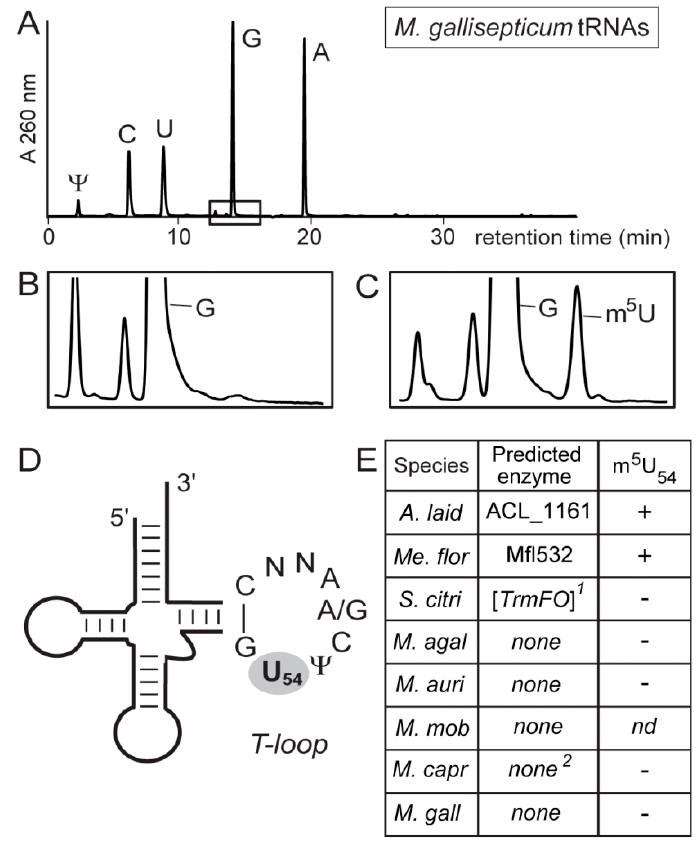
Figure 3. HPLC profiles of tRNA nucleosides from mollicutes bulk tRNAs. ( A ) The digestion products of total tRNAs from M. gallisepticum showing the positions of the unmodified nucleosides and pseudouridine detected by their absorbance at 260 nm (A260 nm). Under the conditions used here, m 5 U elutes in the boxed region after guanosine at approximately 15 min. Enlargement of the boxed region ( B ) for M. gallisepticum and ( C ) for Me. florum, where only the tRNAs of this latter strain contain m 5 U. ( D ) Schematic of the mollicutes tRNAs showing the consensus sequence of the T-loop nucleotides and the position of U54. ( E ) Mollicutes species shown empirically to have (+) or not have (-) m 5 U54 in their tRNAs. This modification correlates with the presence of an active TrmFO enzyme predicted by bioinformatics. Species abbreviations: A. laid , A. laidlawii ; Me. flor , Me. florum ; S. citri , S.